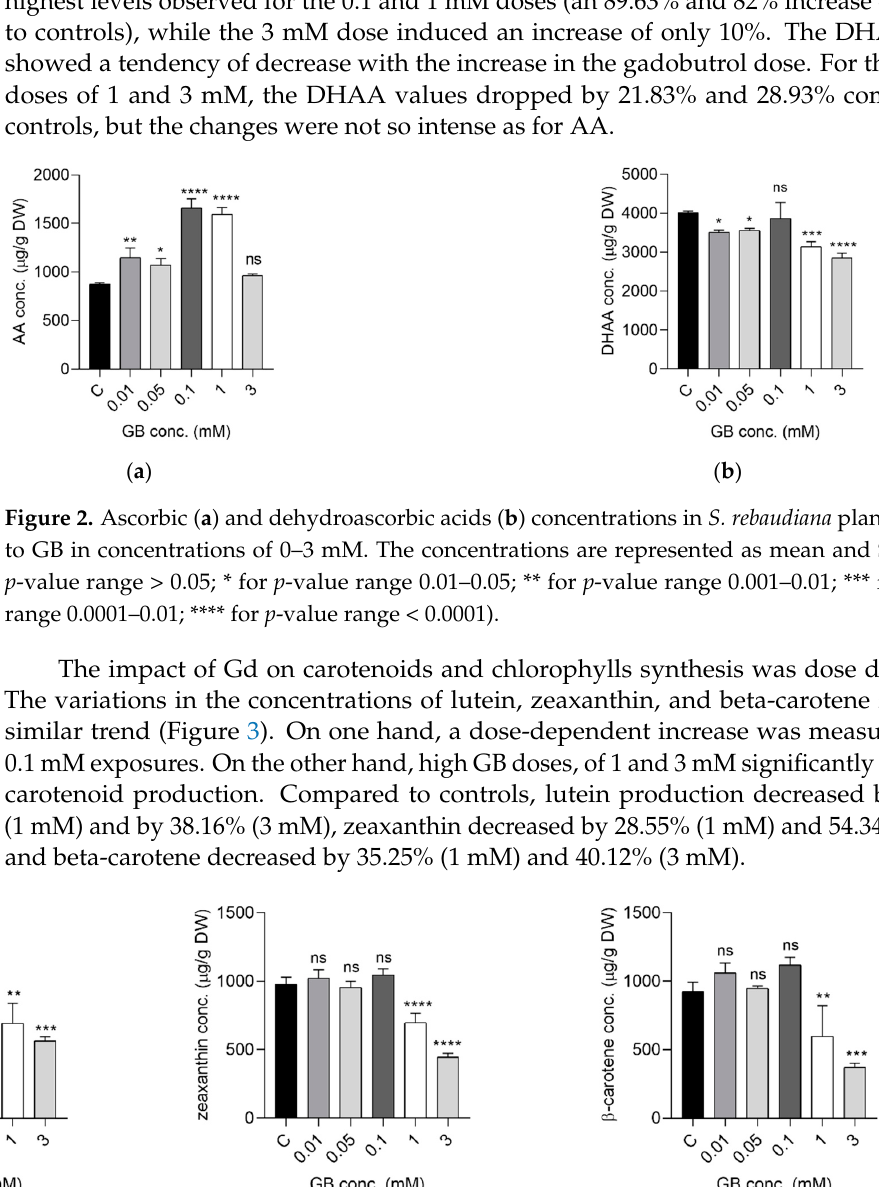
Figure 3. Concentration of carotenoids in S. rebaudiana plants treated with GB in concentrations 0–3 mM; lutein ( a ), zeaxanthin ( b ), β -carotene ( c ) (ns for p -value range > 0.05; ** for p -value range 0.001–0.01; *** for p -value range 0.0001–0.01; **** for p -value range <0.0001).